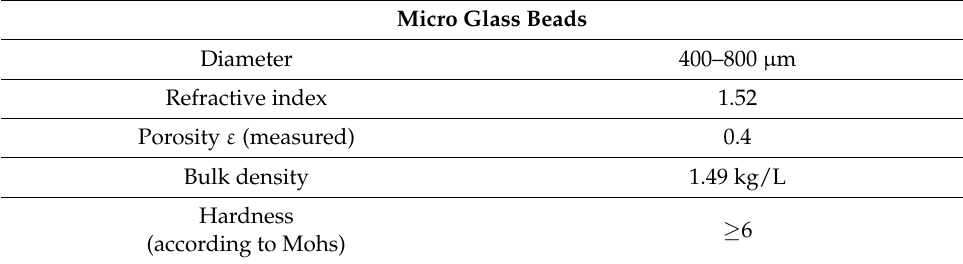
Table 1. Main features of the micro glass beads.